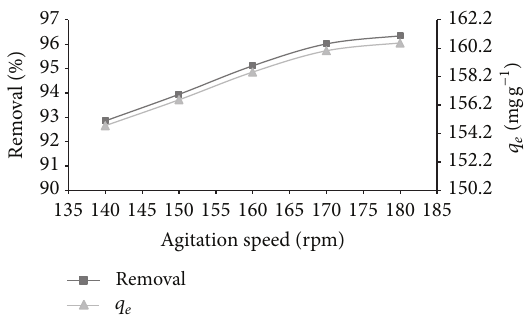
Figure 3: Effect of initial MB concentration (pH = 4 , adsorbent